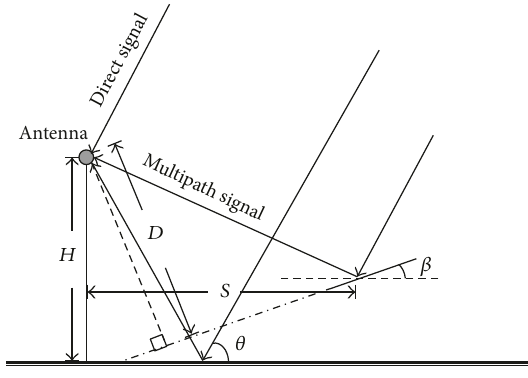
Figure 1: This figure shows how multipath signal is produced. Multipath signals are mainly produced by two kinds of reflective surfaces: horizontal surfaces and inclined surfaces. Elevation angles of multipath signals caused by horizontal surfaces equal to negative elevation angles of direct signals. Elevation angles of multipath signals caused by inclined surfaces depend on both the elevation angles of direct signals and the dip angles of the